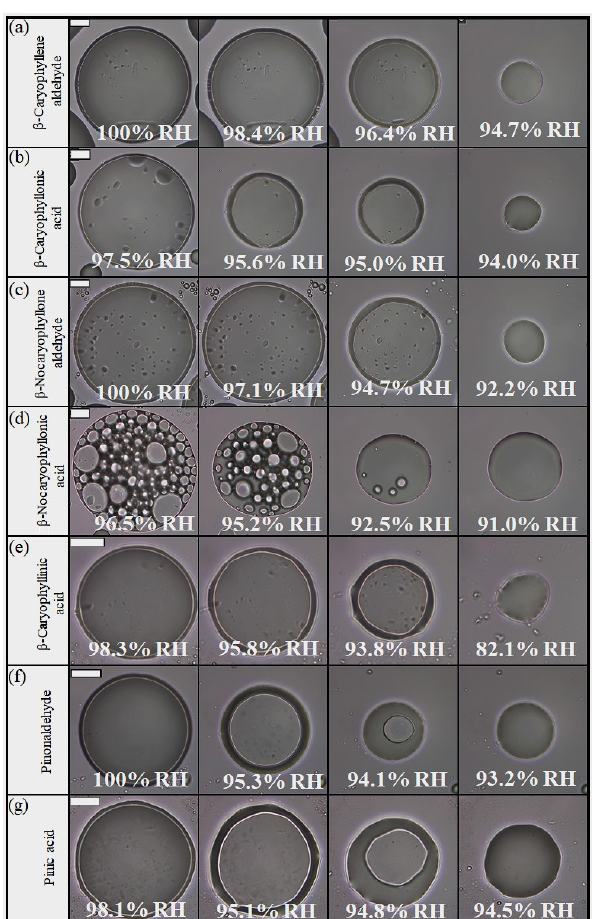
Figure 1. Optical images of particles for decreasing RH: (a) β -caryophyllene aldehyde, (b) β -caryophyllonic acid, (c) β - nocaryophyllone aldehyde, (d) β -nocaryophyllonic acid, (e) β - nocaryophyllinic acid, (f) pinonaldehyde, and (g) pinic acid. The last columns indicate the lower RH boundary for LLPS (LLPS lower ) with decreasing RH. The scale bar is